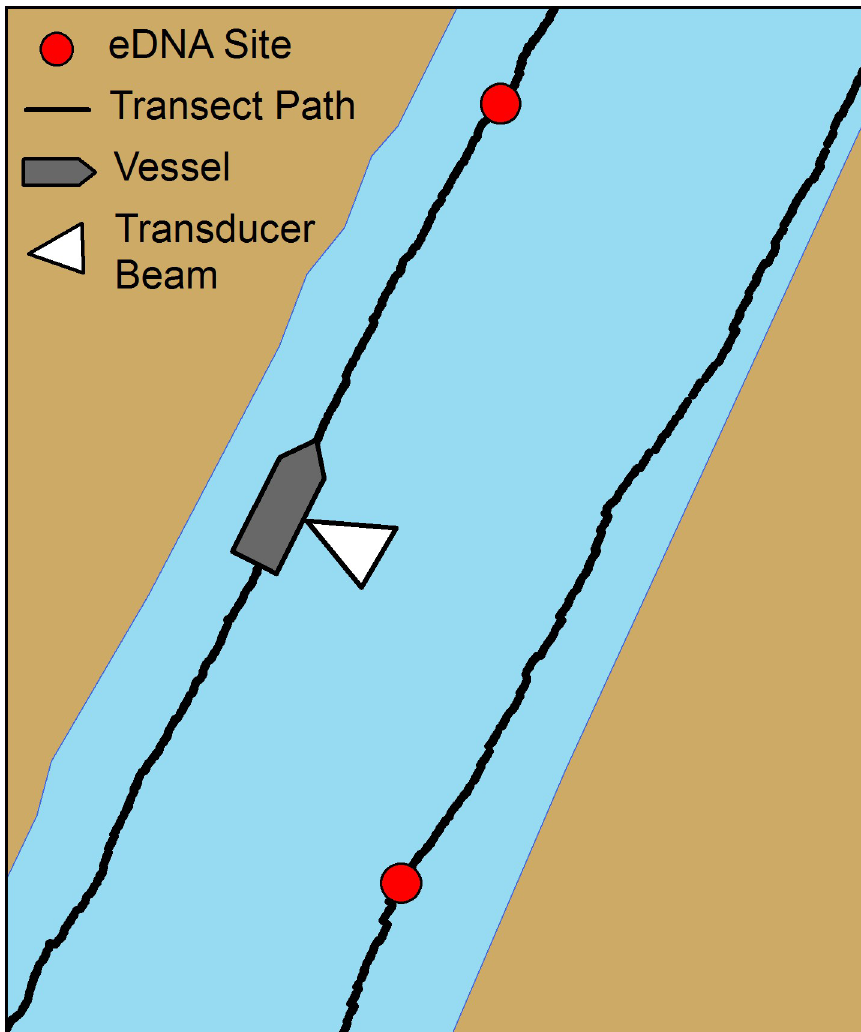
Fig 2. Schematic depicting sampling design for mobile hydroacoustic surveys to assess Silver Carp density and example locations along survey path of surface water sample collection sites (eDNA site) for Silver Carp eDNA analysis. Schematic is not to